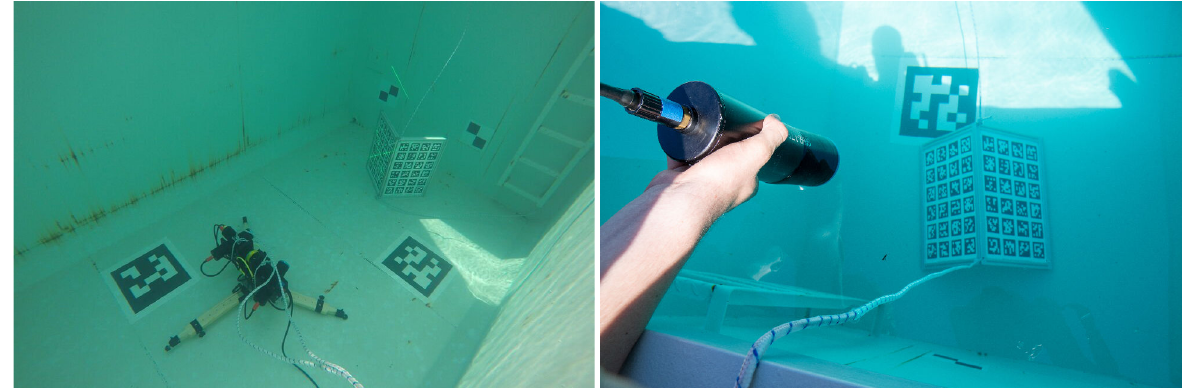
Figure 7. Left: One of the first experiments in the new test environment with our underwater 3D laser line scanner mounted on top of a tripod. Right: Experiments in the test environment for validation of refractive underwater camera models.